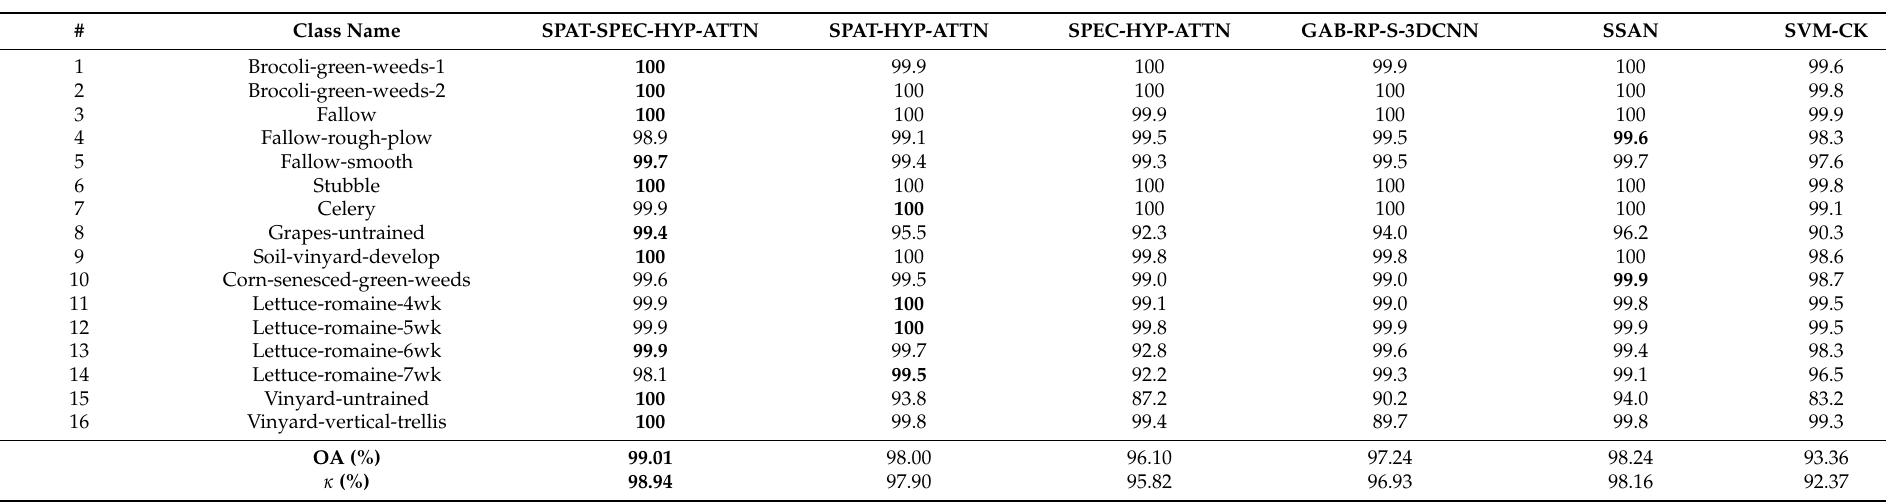
Table 4. Class-specific accuracies of the Salinas dataset for 5% of training data for the proposed classification methodologies and models used for comparison.